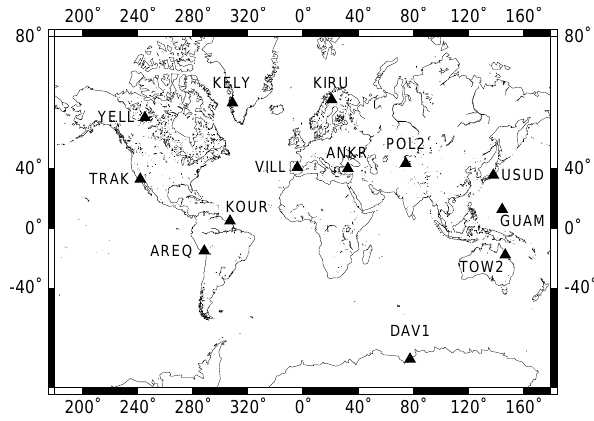
Figure 1. IGS permanent GPS stations used in the